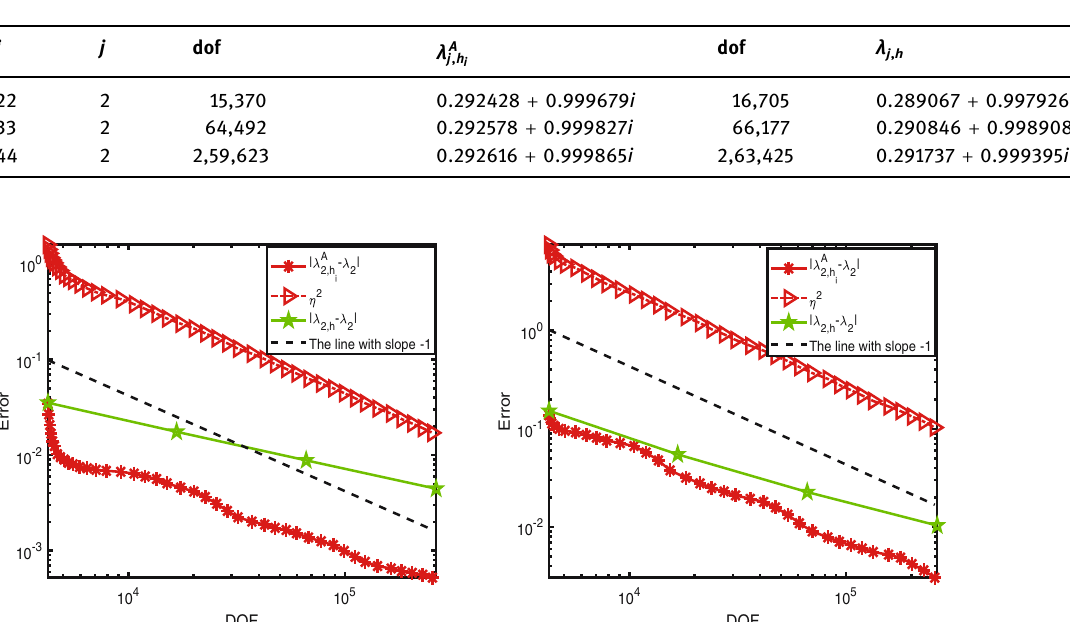
Table 4: The second eigenvalue for ( 2.1 ) – ( 2.2 ) : the square with a slit ( k = 1, n ( x ) = 4 + 4 i )